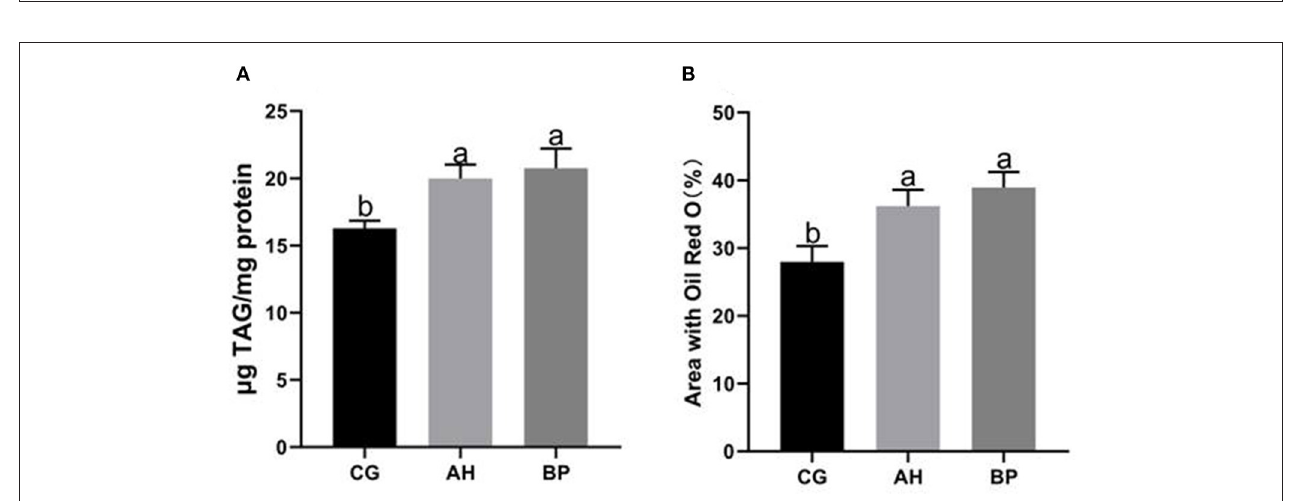
FIGURE 3 | Effect of alfalfa flavone and hybrid Broussonetia papyrifera flavone on the viability of gMECs. (A) Alfalfa flavone; (B) Hybrid Broussonetia papyrifera flavone. Mean values without common superscript (a, b, and c) differ significantly among CG, AH, and BP groups ( p < 0.05).